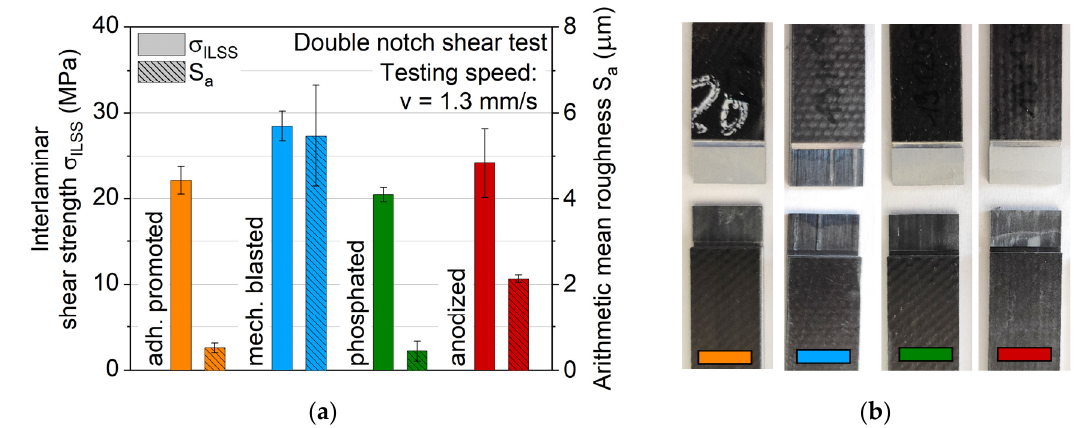
Figure 6. Results of ( a ) an interlaminar shear test of hybrid laminates with surface-treated aluminum alloy AA6082-T4 and a graded structure of glass and carbon fiber-reinforced PA 6 in a 1 / 2 configuration; ( b ) fractography images.